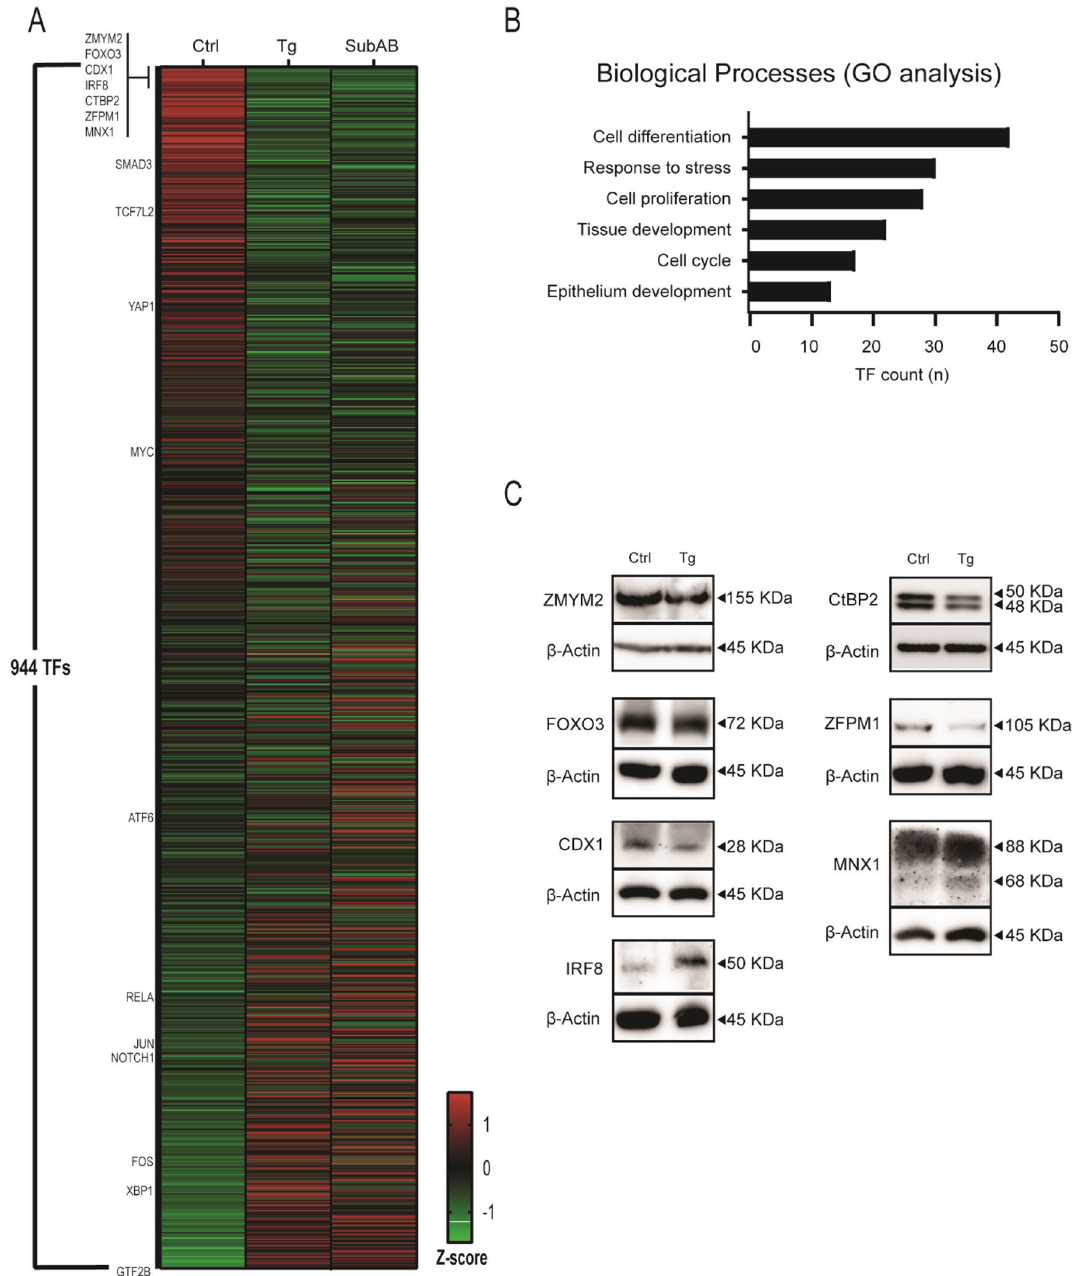
Figure 1. ER stress induced loss of stemness is characterized by altered activity of a set of transcription factors. ( A ) Heatmap based on average Z-scores of performed CatTFRE assay on human LS147T cells treated for 2 h with DMSO (n = 3) thapsigargin (n = 3) or SubAB (n = 2). Upper selection contains transcription factors with most downregulated binding to DNA template. ( B ) DAVID gene ontology (GO) analysis on top 100 most downregulated transcription factors, presented in the heatmap. ( C ) Protein analysis by western blot of the heatmap selected transcription factors, in LS174T cells, 24 h after thapsigargin treatment. Full-length blots/ gels are presented in Supplementary Immunoblotting Data Figure 1. All western blot images were generated and exported using ImageQuant LAS 4000 software and cropped and labeled using Adobe Illustrator software version